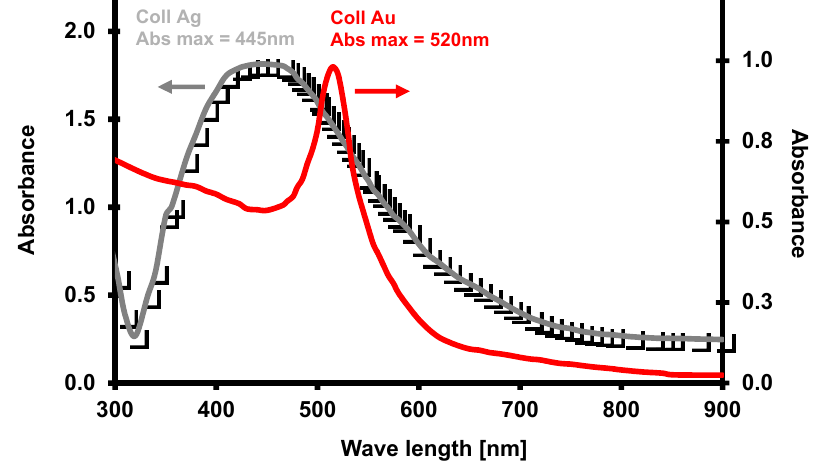
Figure 2. UV-VIS spectral spectra of the fraction of 4-5000 x g of gold and colloidal silver. Molecules 2019 , 24 , 606